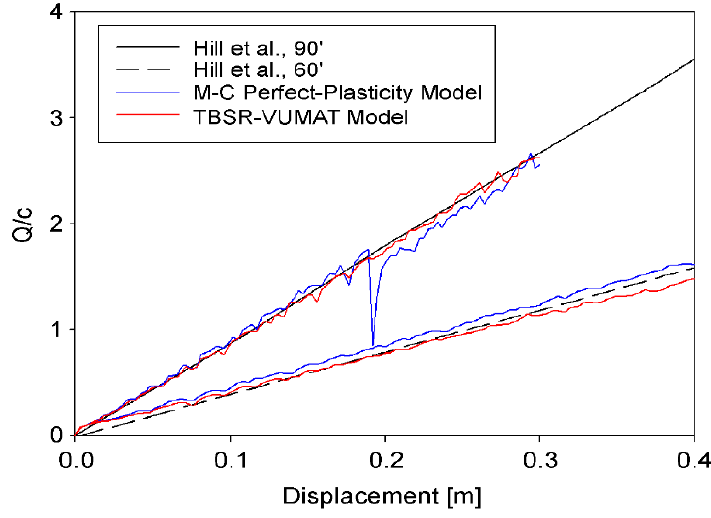
Figure 8. Influence of 𝛽 on wedge indentation in CEL analysis [25].